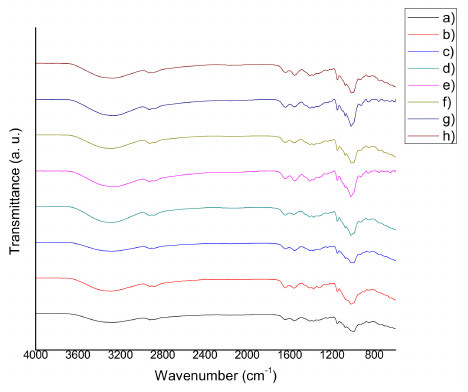
Figure 2. FTIR spectra of ( a ) QS2 vs. ( b ) QSA0.5; ( c ) QSAm0.5; ( d ) QSB0.5; ( e ) QSG0.5; ( f ) QSO0.5; ( g ) QSP0.5 and ( h )